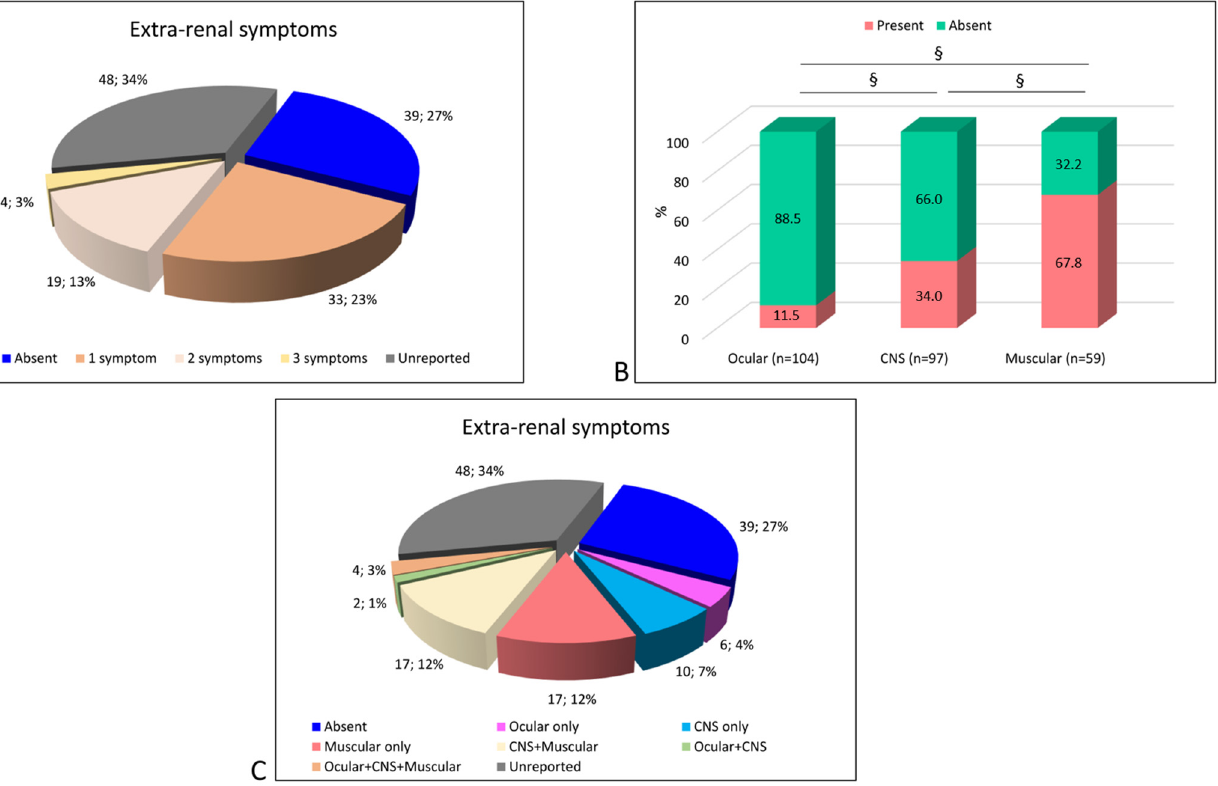
Figure 1. Extra-renal symptoms in DD2 patients. ( A ) Distribution by number of extra-renal symptoms presented by each subject (number of patients; percentage). ( B ) Graph bar showing the percentage of ocular, CNS or muscular involvement in DD2 patients. Fisher’s exact test § p < 0.01. ( C ) Detailed description of extra-renal symptoms’ combinations in DD2 patients (number of patients; percentage).